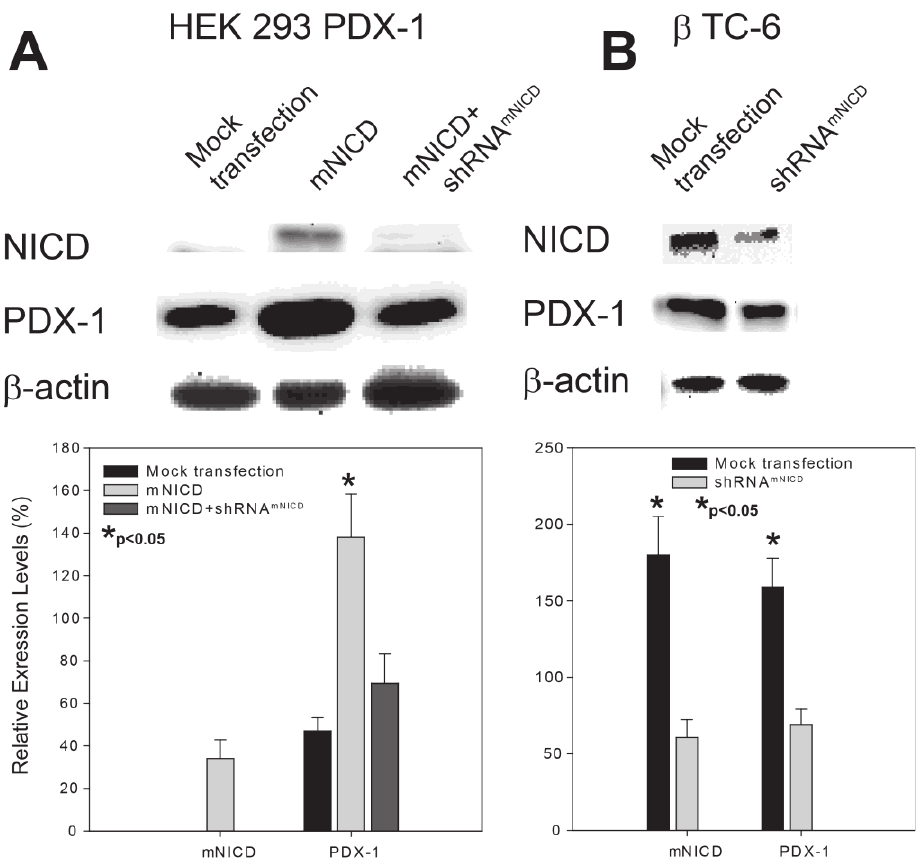
Figure 1. NICD up-regulates PDX-1 expression in PDX-1 stable HEK293 and β -TC-6 cells. ( A ) pcDNA mNICD with shRNA mNICD_scrambled or shRNA mNICD were co-transfected into PDX-1 HEK293 cells using Lipofectamine 2000. ( B ) shRNA mNICD was transfected